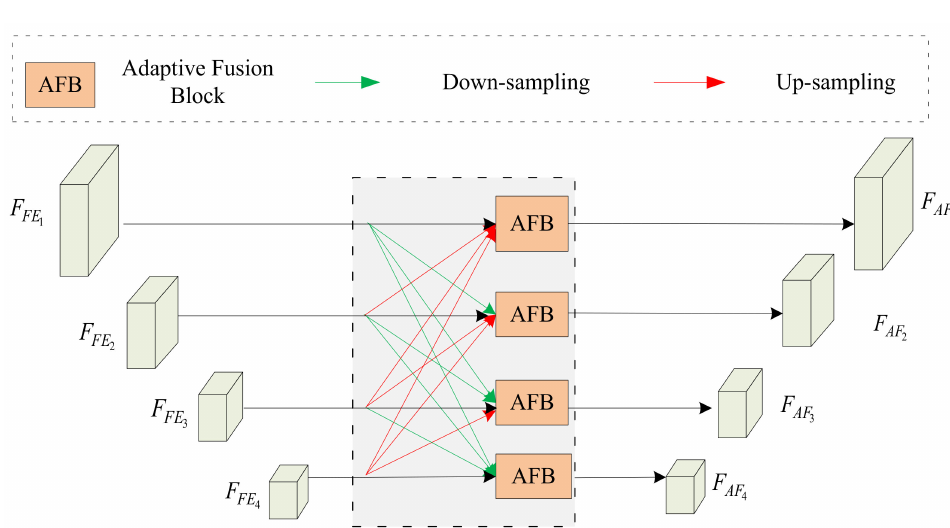
Figure 4. Feature fusion